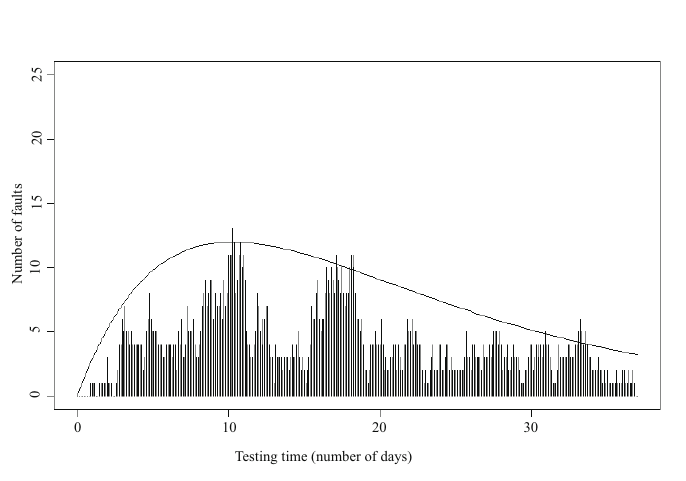
Figure 7. Behavior of the number of faults being corrected (the correction time is 0.5 day/fault on average, DSS data).